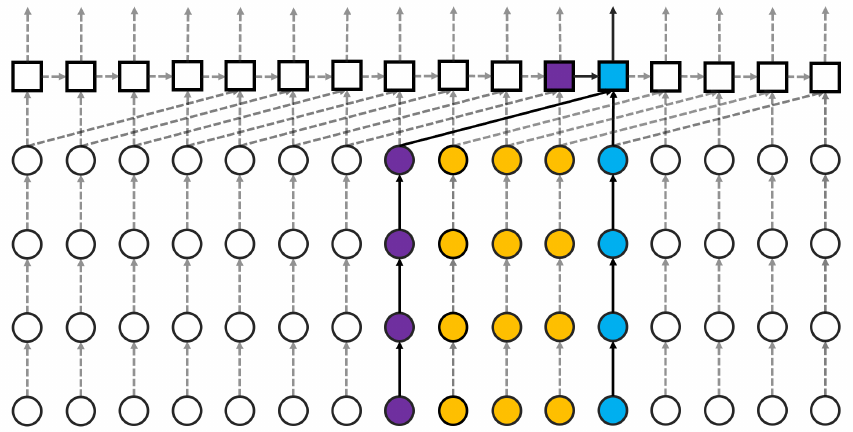
Figure 12. Memory usage process for late fusion + LSTM (Note: Purple denotes data in the past and currently needed, yellow denotes memory to be stored for the future, and blue denotes the number of nodes needed in current